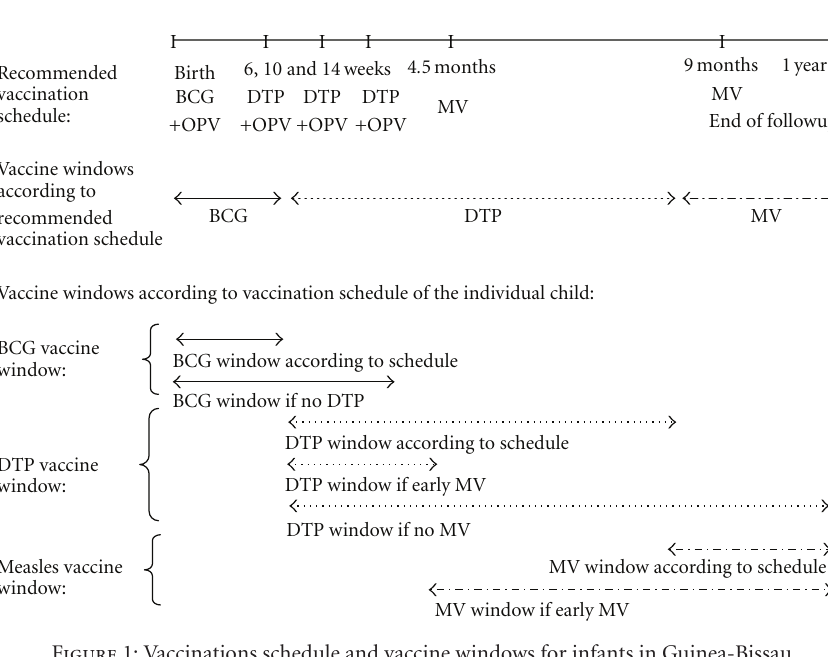
Figure 1: Vaccinations schedule and vaccine windows for infants in